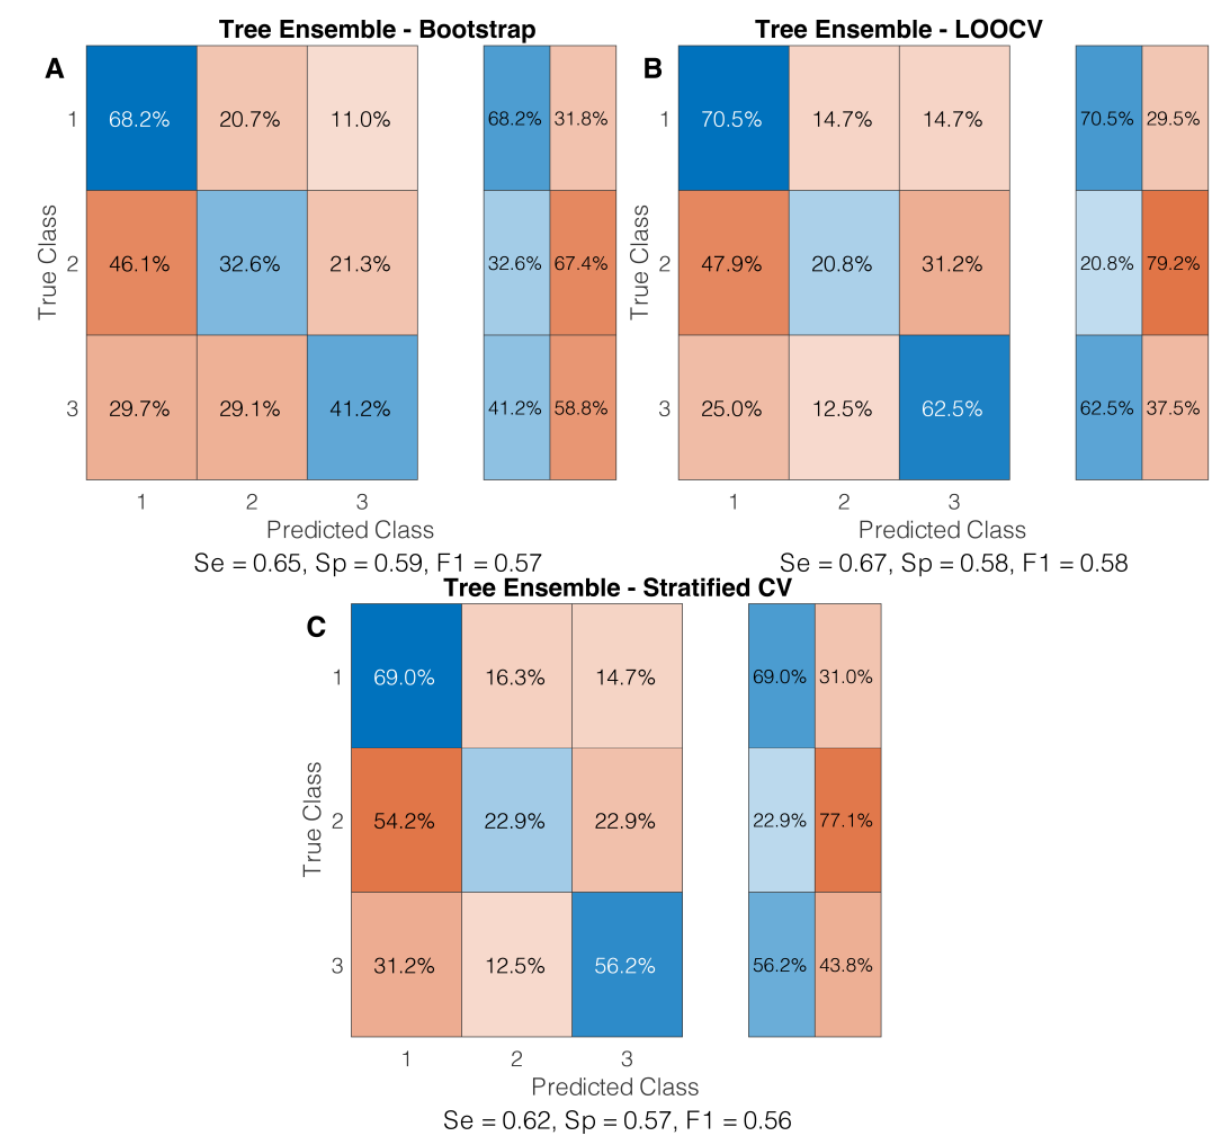
Figure 5. Shows three confusion matrices for the tree ensemble with different types of cross-validation. ( A ) Shows bootstrap CV, ( B ) shows leave-one-out CV and ( C ) shows stratified CV. All the models in this figure were cross-validated with five-fold cross-validation.